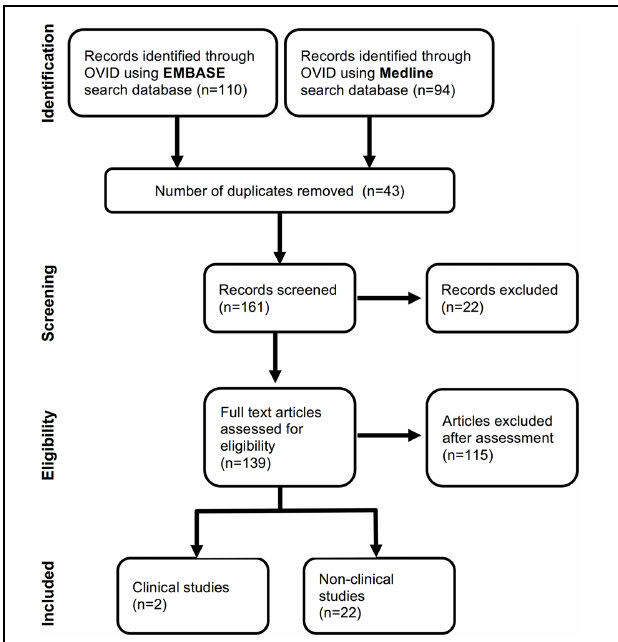
FIGURE 1 | Flow chart illustrating selection of studies for systematic review. Initial exclusions were made following assessment of abstracts. Further studies were excluded after full text assessment due to language restrictions or study not looking at the effects of a voltage-gated Na + channels (VGSC)-inhibiting drug listed in Table 1 . The final shortlist of studies was achieved by scoring study quality and evidence against the standardized pre-piloted criteria in Supplementary Table S3. A minimum score of 3/5 was required for